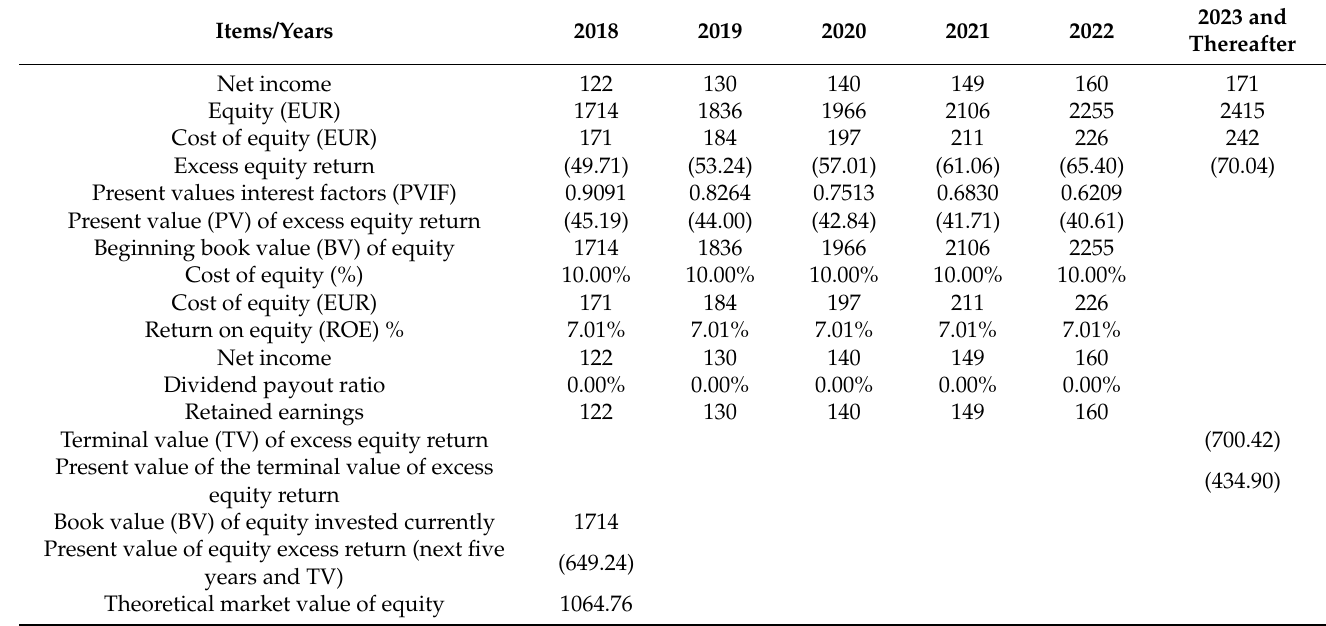
Table 3. Excess return valuation—Luminor Group AB (in